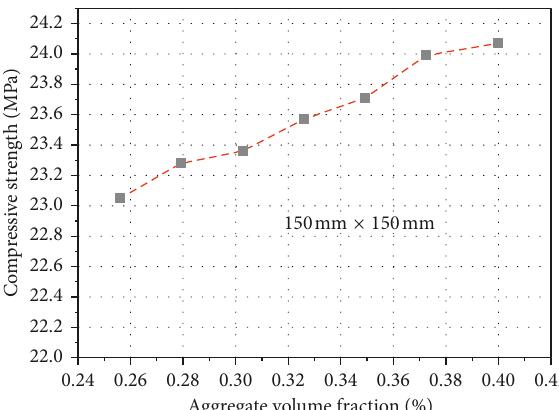
Figure 24: Comparison of compressive strength with different coarse aggregate contents.